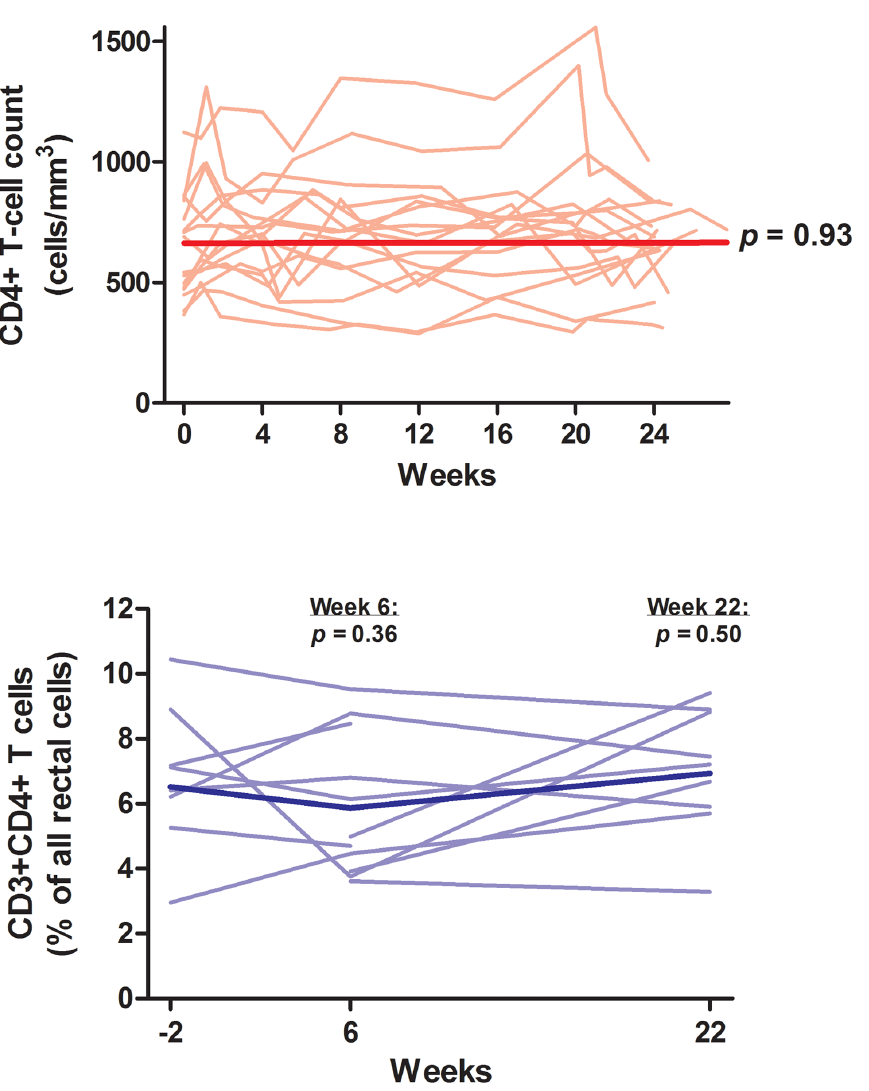
Figure 1. Change in peripheral CD4 + T cell count and rectal CD4 + T cell content. Thin lines indicate data for each individual subject. The thick line indicates the estimated mean value over time from mixed effects linear regression. P-values refer to change from baseline at each referenced time-point. doi:10.1371/journal.ppat.1003691.g001 (mean 1.61-fold decrease, 95% CI 3.6-fold decrease to 1.37-fold increase, p = 0.24) T cell responses in the rectum at week 22.